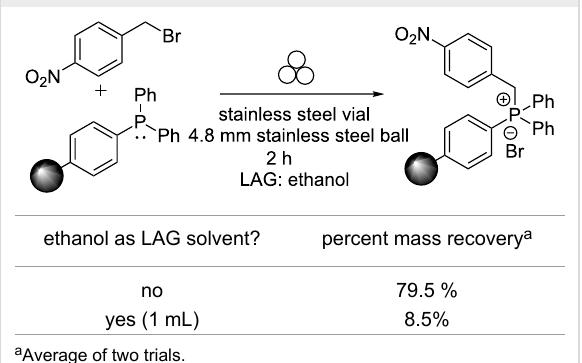
Table 5: How much 4-nitrobenzyl bromide adds to the polymer-sup- ported triphenylphosphine, PS-C 6 H 4 -PPh 2 ?